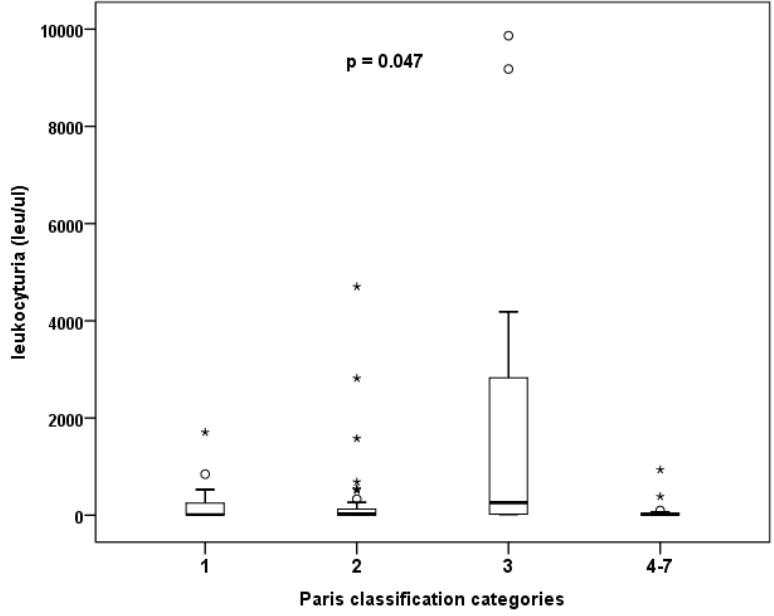
Table 6. Effect of erythrocyturia and leukocyturia on The Paris System. The Paris System Category